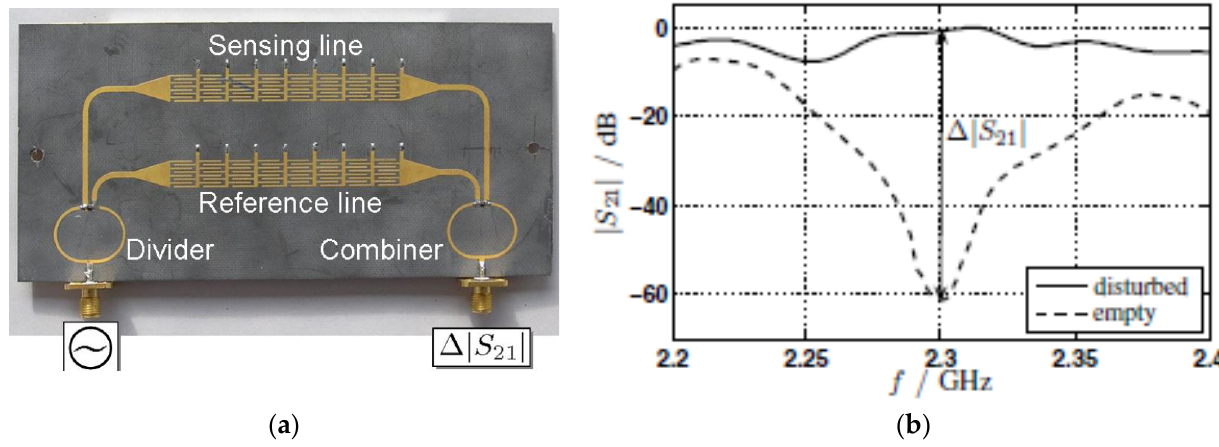
Figure 15. Photograph of the CRLH transmission line based differential-mode phase variation sensor ( a ) and comparison between the transmission coefficients for the empty case (unloaded sensing line) and for the sensing line loaded with a MUT ( b ). Reprinted with permission from [38].